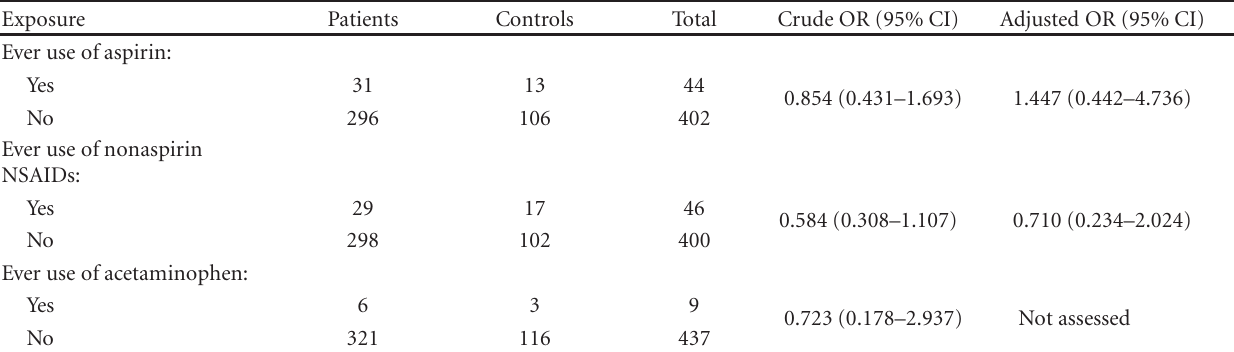
Table 2: Analgesic use and risk of first primary invasive or In situ